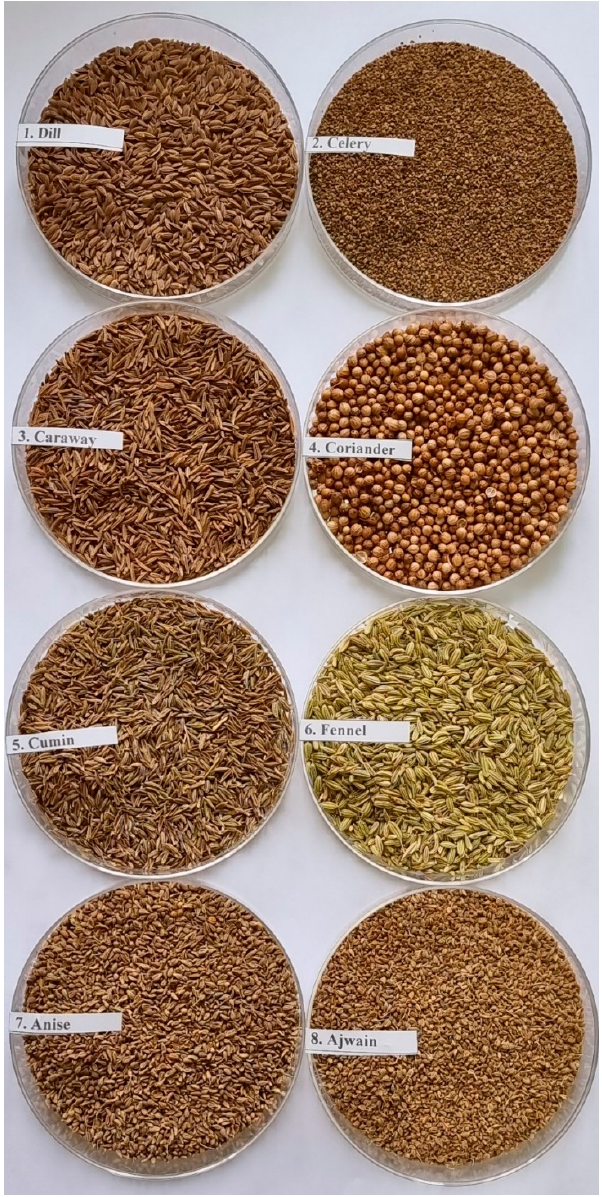
Figure A1. Apiaceae family spices used in the present study. Scale: the diameter of the Petri dish is 90 mm.